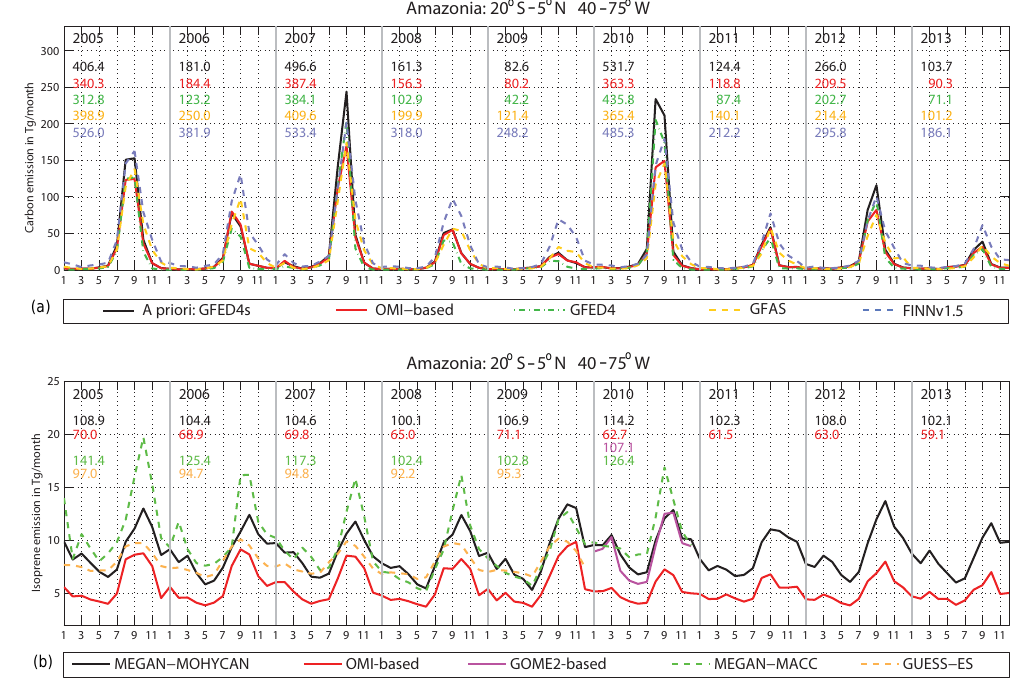
Figure 9. Seasonal and interannual variation of biomass burning emissions and isoprene emissions from bottom–up and top–down estimates over Amazonia (Fig. 3). Units are Tg C per month for biomass burning fluxes and Tg of isoprene per month for biogenic emissions. The annual emission flux per inventory is given as inset